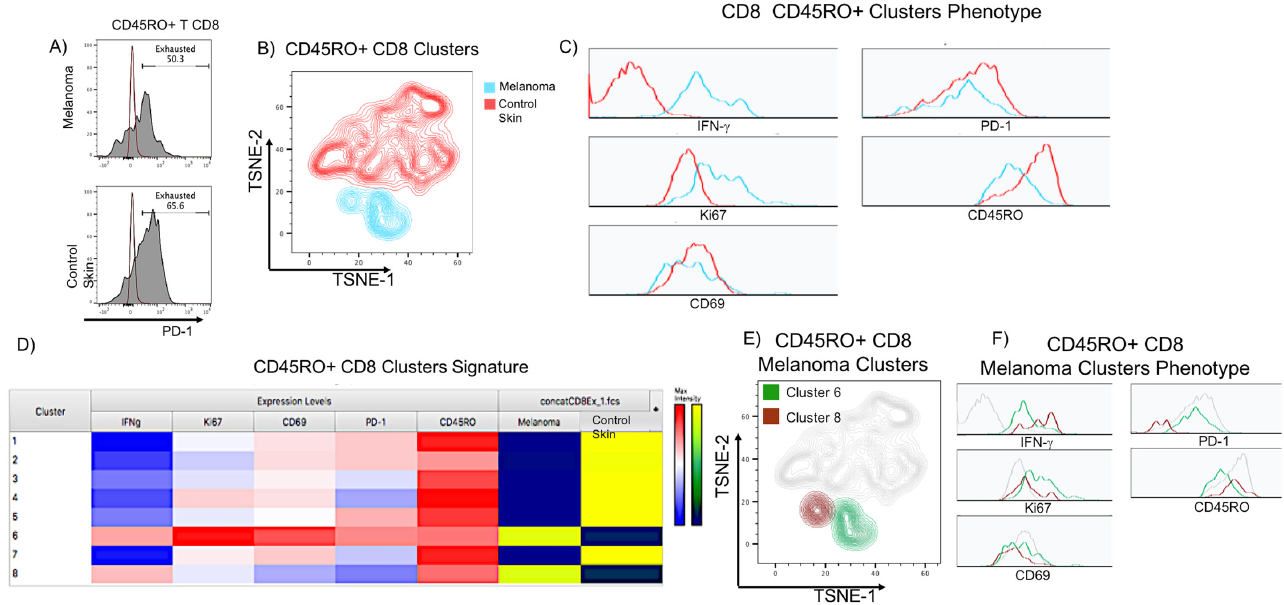
Figure 7. Flow cytometry analysis validates the presence of functional PD-1+ CD8 T cells in the stroma of acral melanoma. Stromal cells were obtained from one acral melanoma (AM) and one healthy skin control (SC) derived from a surgical resection unrelated to cancer. Memory CD45RO+ CD8 T cells were clustered together for further analysis. ( A ) Histogram of PD-1 expression on CD45RO+ CD8 T cells (gray histograms), the autofluorescence control is shown in maroon histograms. ( B ) CD45RO+ CD8 T cells non-supervised t-distributed stochastic neighborhood embedding (t-SNE) clustering. Clusters derived from the melanoma and skin control samples are shown in blue and red, respectively. The expression of IFN- γ , KI-67, CD45RO, CD69, and PD-1 was used for clustering. ( C ) Histograms of the normalized expression of the parameters used for the clustering in ( B ), melanoma (blue) and skin control (red) clusters. ( D ) Heatmap of the normalized expression of the parameters used in ( B ). ( E ) Topological identity of melanoma CD8 T cell clusters obtained in ( D ). Cluster 6 (green), Cluster 8 (brown). ( F ) Histograms of the normalized expression of the parameters used for the clustering in ( B ), cluster 6 (green) cluster 8 (brown).